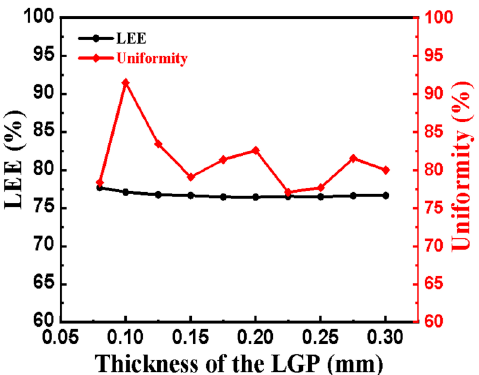
Figure 6. Relationships between the thickness of the LGP and the LEE and uniformity.